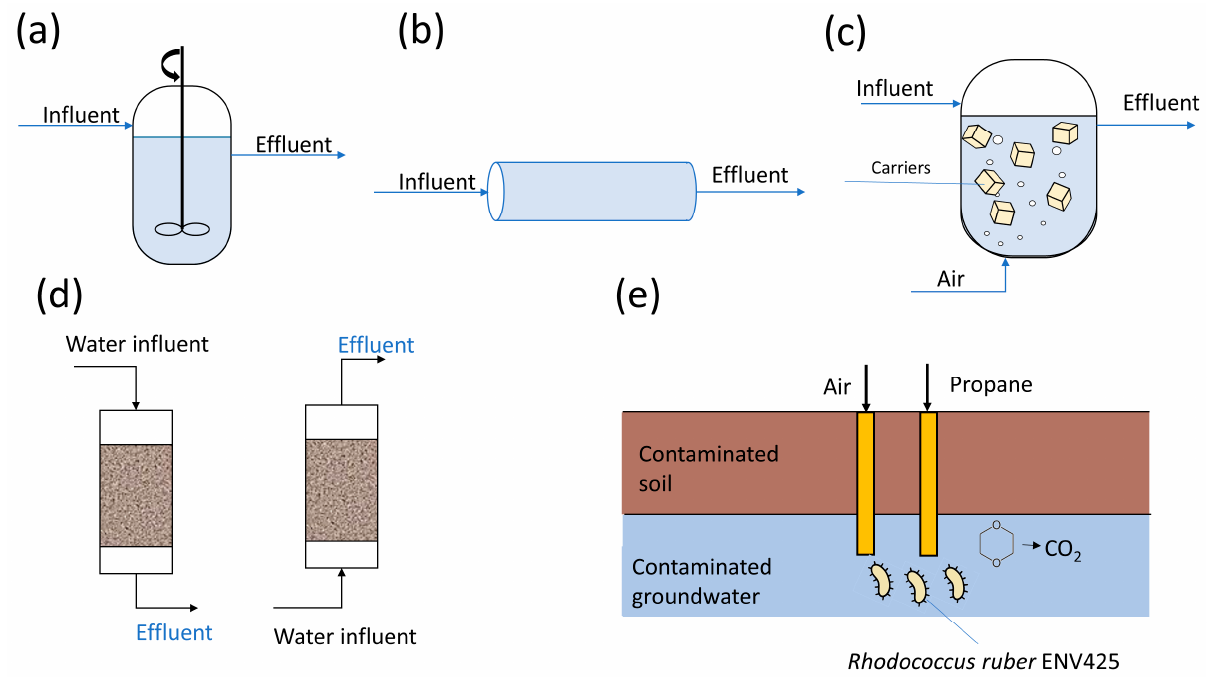
Figure 3. Schematic diagram of ( a ) continuous stirred tank bioreactor (CSTR), ( b ) plug-flow bioreactor, ( c ) immobilized cell bioreactor, ( d ) down-flow and up-flow biofiltration system and ( e ) biosparging for biological 1,4-dioxane treatment.